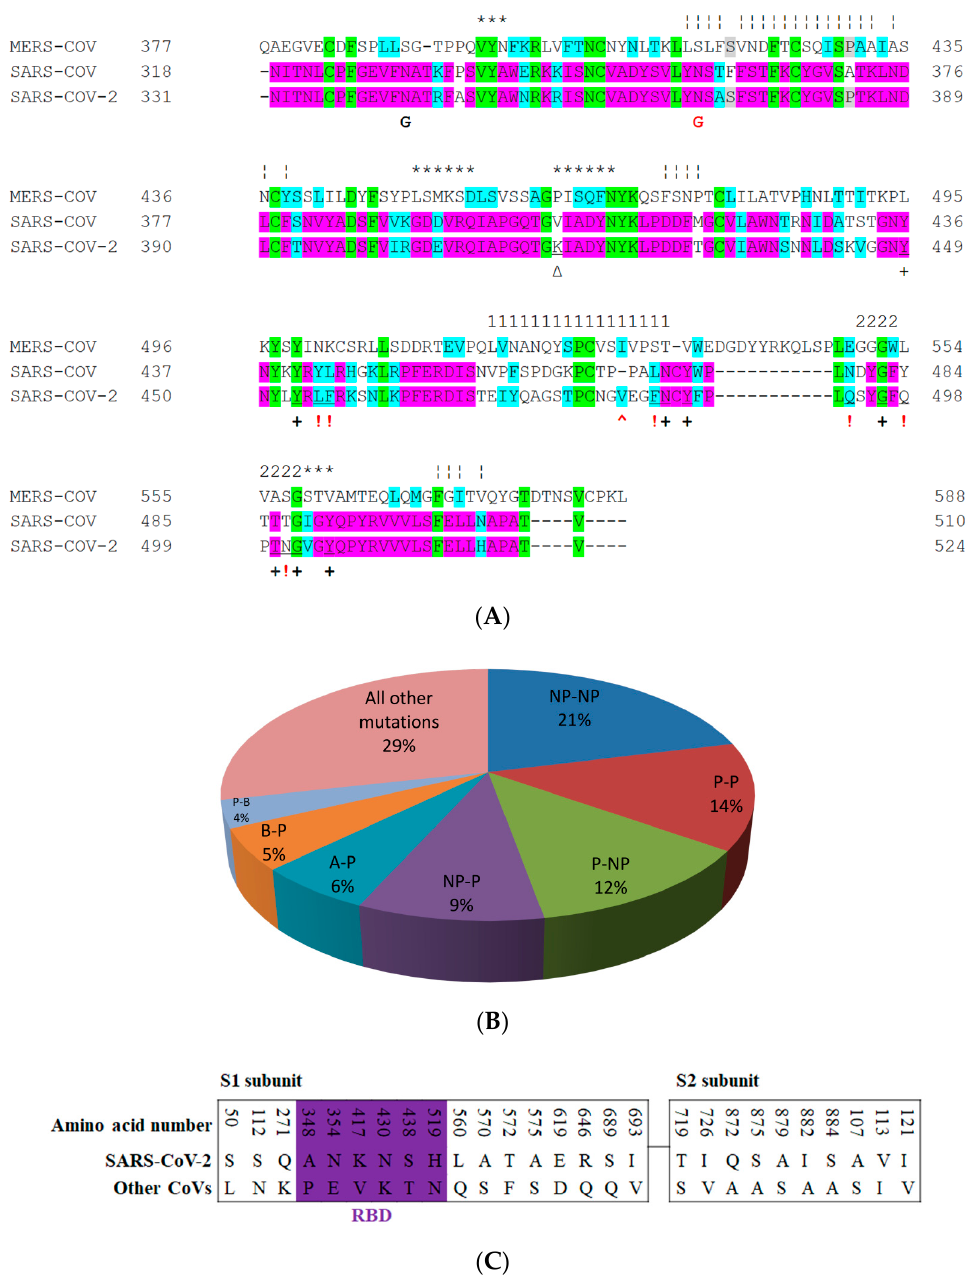
Figure 3. Aligned sequences of RBD of SARS-CoV-2 with other coronaviruses, and rates of all reported mutations in the S protein of SARS-CoV and SARS-CoV-2. ( A ) Aligned sequences (found through use of Clustalw at www.genome.jp / tools-bin / clustalw; [43]) of RBD of SARS-CoV-2 with those of SARS-CoV and MERS-CoV. Green color indicates positions that have a fully conserved residue between the three sequences. Pink color indicates conserved residues between SARS-CoV-2 and SARS-CoV, while grey color indicates conserved residues between SARS-CoV-2 and MERS-CoV. Cyan indicates conservation between residues of strongly similar properties that score > 0.5 in the Gonnet PAM250 matrix [36]. “ + ” indicates critical, identical amino acids in SARS-CoV-2 and SARS-CoV based on previous studies, while “!” indicates critical, non-identical amino acids in SARS-CoV-2 and SARS-CoV. “ ∆ ” refers to the amino acid that has salt bridges in SARS-CoV-2 but no interactions in SARS-CoV; this amino acid is located outside the RBM motif. “ˆ” refers to the only insertion in the RBD domain (terminal region (TR)1 region) of SARS-CoV-2. “*” indicates amino acids of the upper core region, “1” for TR1, “2” for TR2. “¦” refers to the binding site of the CR3022 antibody, one of the main binding antibodies. “G” refers to potential glycosylated sites (black for conservative